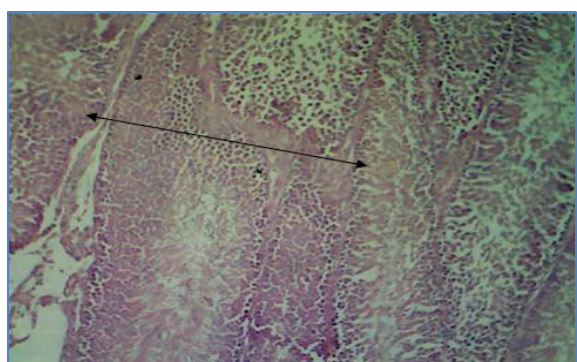
Figure, 15: Section in testis of animal treated with CdCl 2 and Eruca Sativa (G2). Shows normal arrangement of seminiferous tubules ( ) (H and E stain 10X).